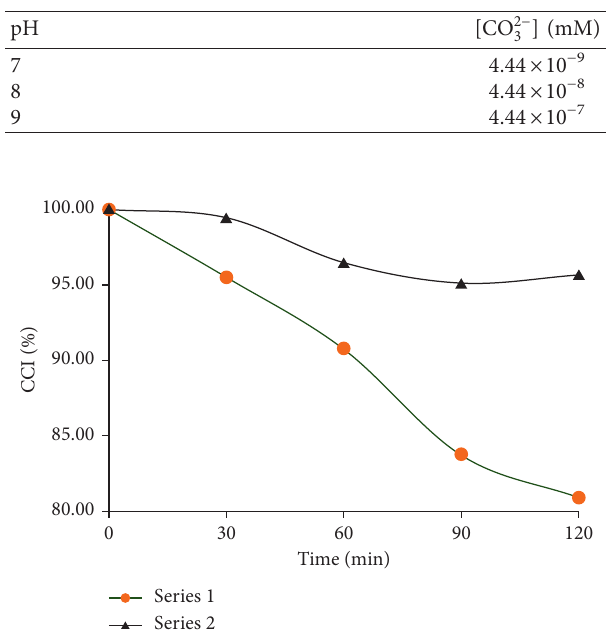
Figure 5: Effect of radiation energy on calcium carbonate scale inhibition, as a function of